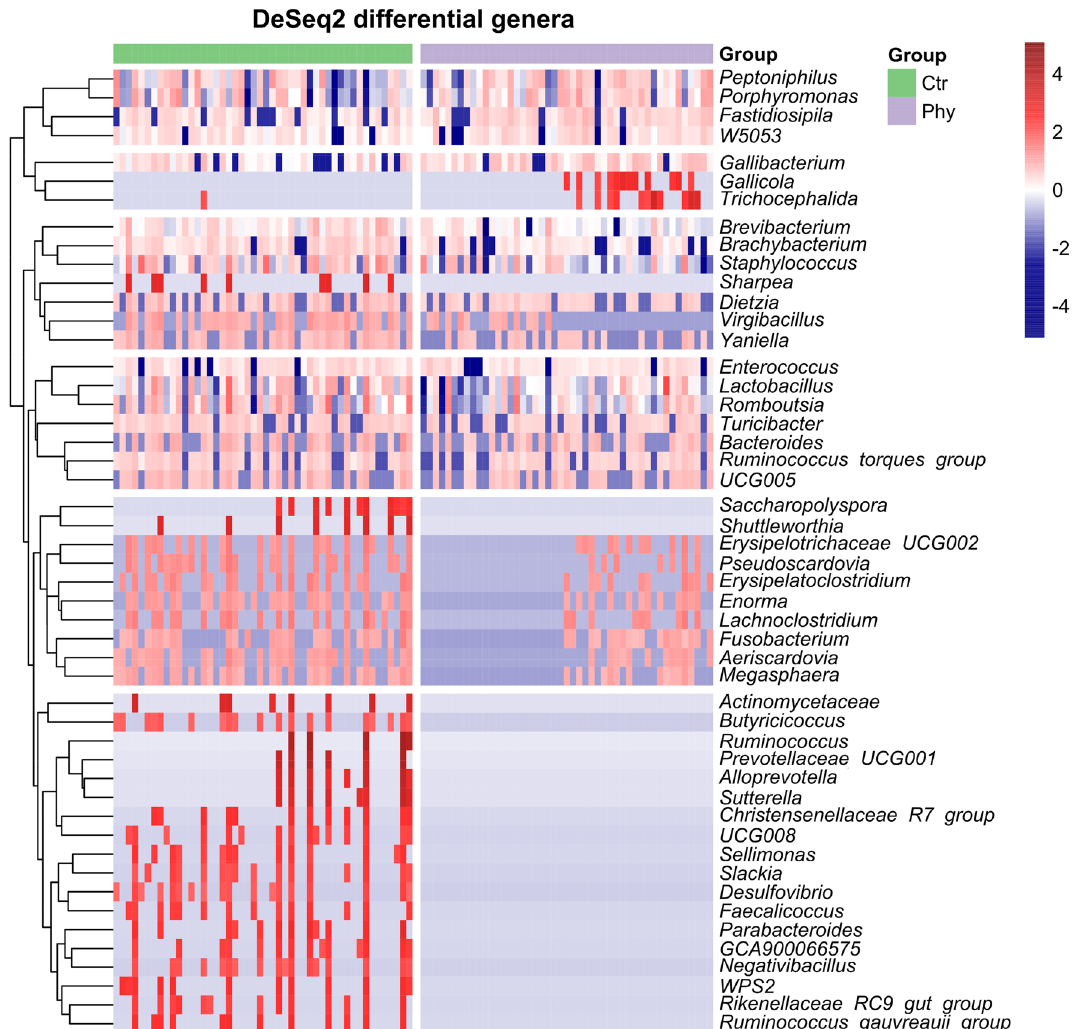
Figure 4. DeSeq2 selected significant genera. The top 2 clusters represented by seven genera are increased in abundance in the phytogen supplemented group. The heatmap was generated in the pheatmap R package using mean scaled, log2 transformed abundance data with the normalised range from low (blue) to high (red) abundance shown on the scale